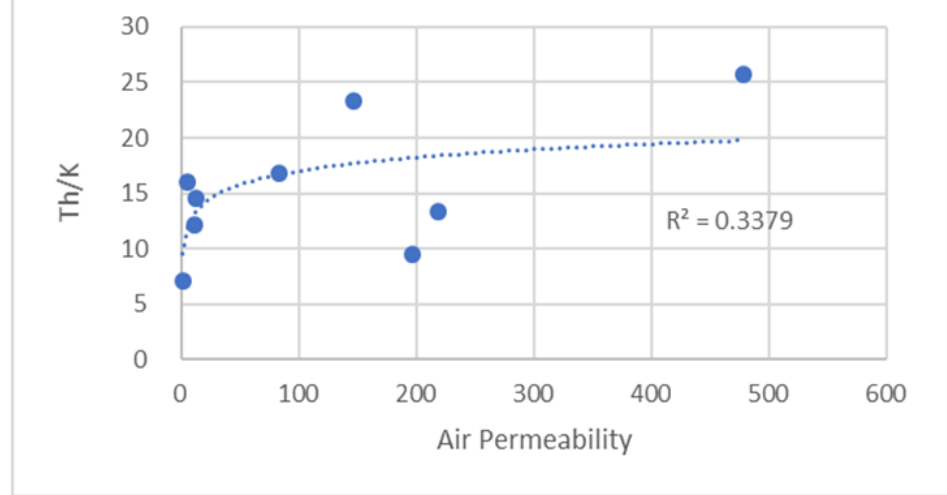
Figure 27. A scatter plot showing the relations of the Th/K ratio and air permeability.